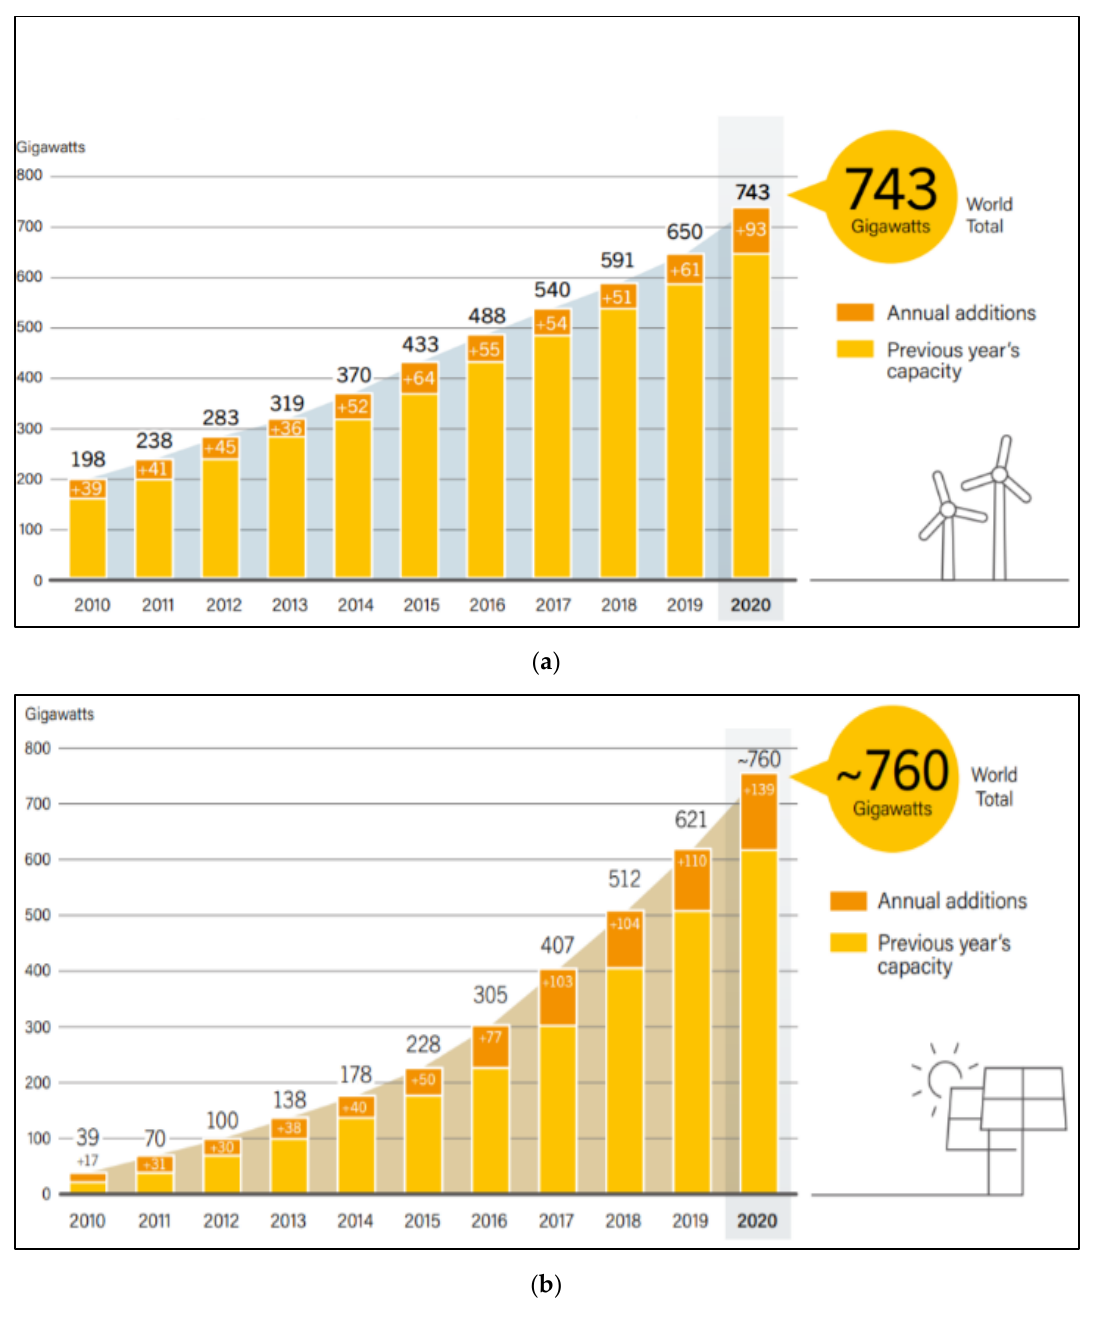
Figure 2. ( a , b ) Solar PV and Wind Global Capacity and Annual Additions, 2010 – 2020.